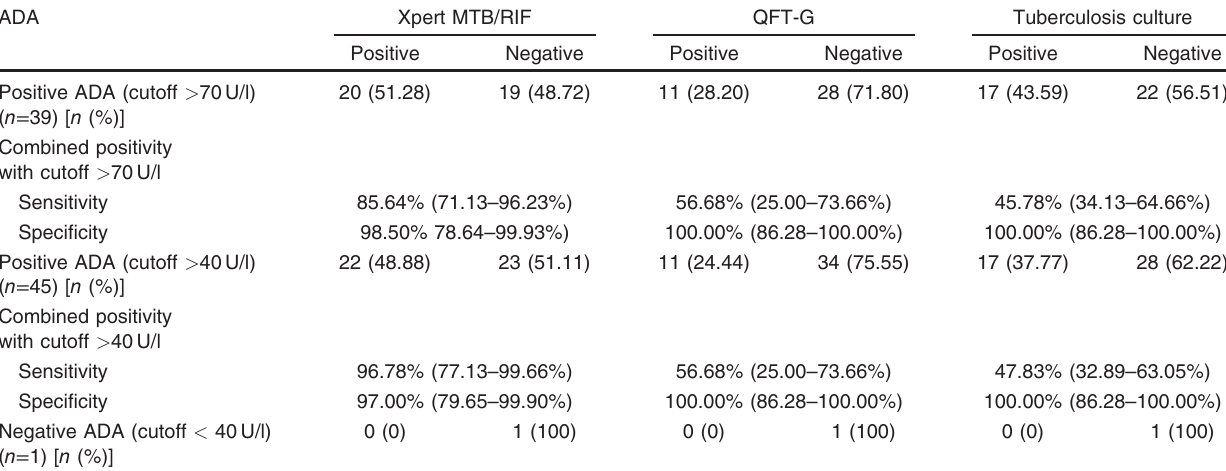
Table 3 Comparative analysis of positivity of different levels adenosine deaminase with positive and negative results of Xpert MTB/RIF, QFT-G, and tuberculosis culture ADA Xpert